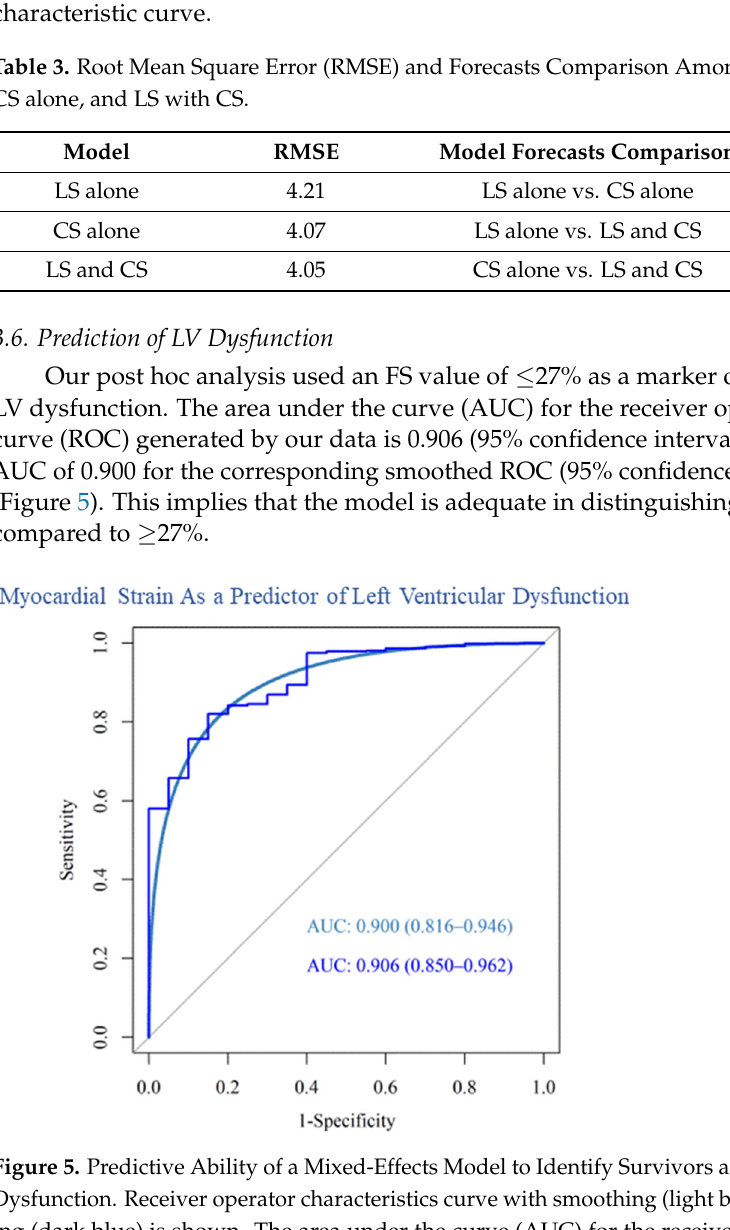
Figure 4. ( a , b ). Estimated Fractional Shortening Using Longitudinal or Circumferential Strain. Fi tt ed fractional shortening (FS) values (circles) across longitudinal strain (LS) values ( a ) and circumferential strain (CS) values ( b ). Loess-smoothed curve of the fi tt ed FS values, along with the corresponding 95% con fi dence band, is also provided.